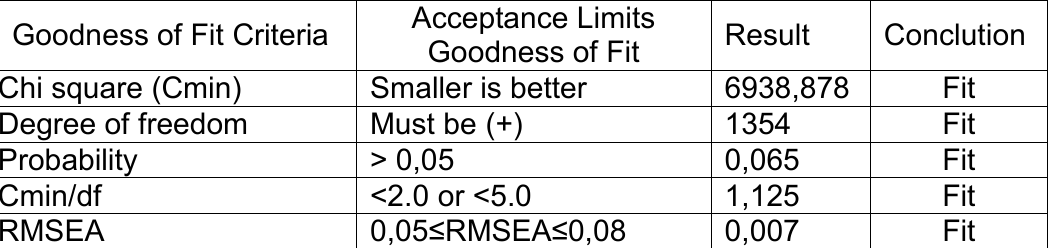
Table 3. Goodness of Fit